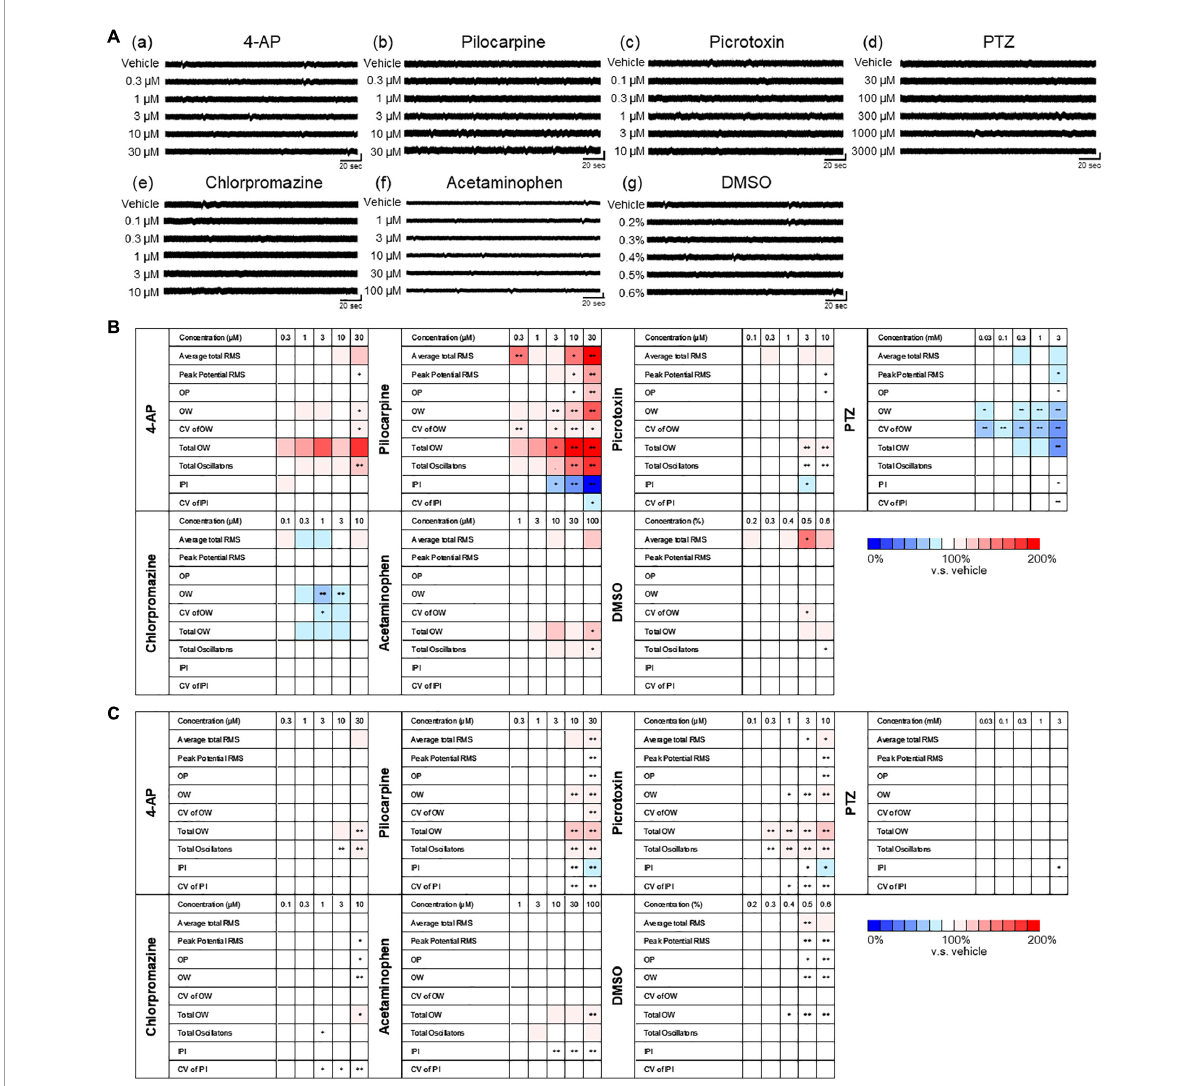
FIGURE6 Drug responses of human iPSC-derived astrocytes detected by MEA. (A) Representative oscillation waveform after the cumulative administration of seizurogenic compounds (a) 4-AP, (b) pilocarpine, (c) picrotoxin, (d) PTZ, and (e) chlorpromazine, and neutral compounds (f) acetaminophen and (g) DMSO. Compounds were added to astrocytes during 2–3 weeks of the culture. Vertical scale bar, 40 µ V; horizontal scale bar, 20 ms. (B,C) Heatmaps of the analytical parameters of seizurogenic compounds (4-AP, n = 6; pilocarpine, n = 6; picrotoxin, n = 6; chlorpromazine, n = 6) and neutral compounds (acetaminophen, n = 6; DMSO, n = 6) in DC potential (A) and in delta band (B) . One-way ANOVA followed by Dunnett’s test, * p < 0.05, ** p < 0.01 versus